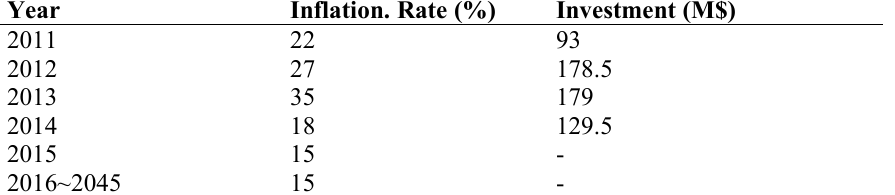
Table 15 . Investment method and the assumed Inflation rate of Iran in the project lifetime